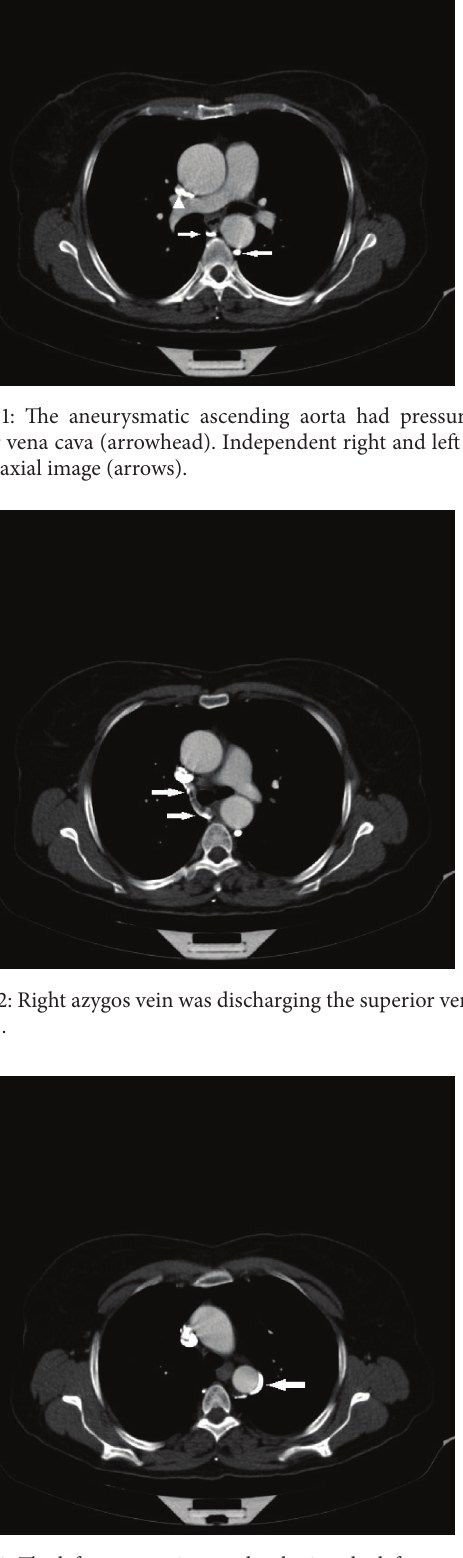
Figure 3: The left azygos vein was developing the left aspect of the thoracal aorta (arrow).